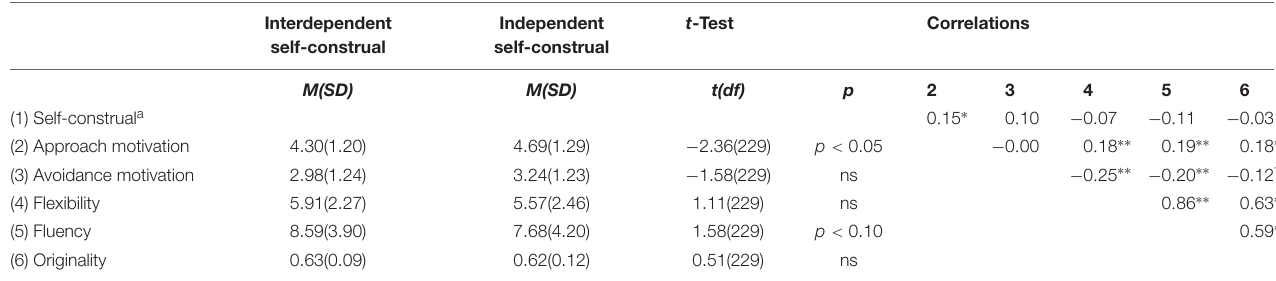
TABLE 1 | Study 1 descriptive statistics and